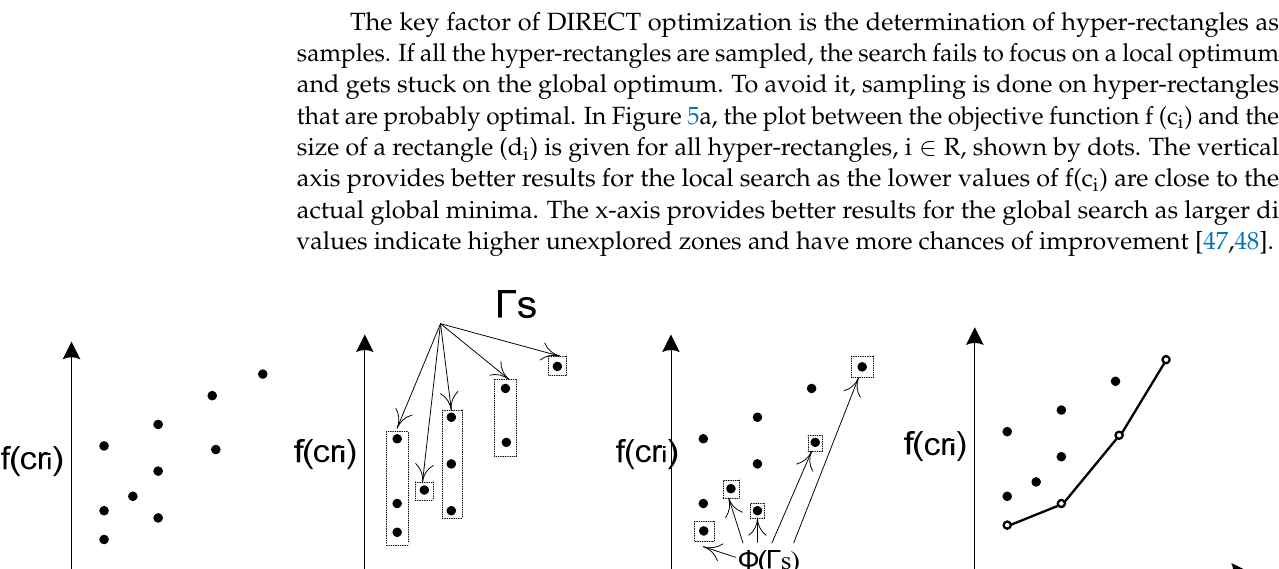
Table 2. Design variable parameters.